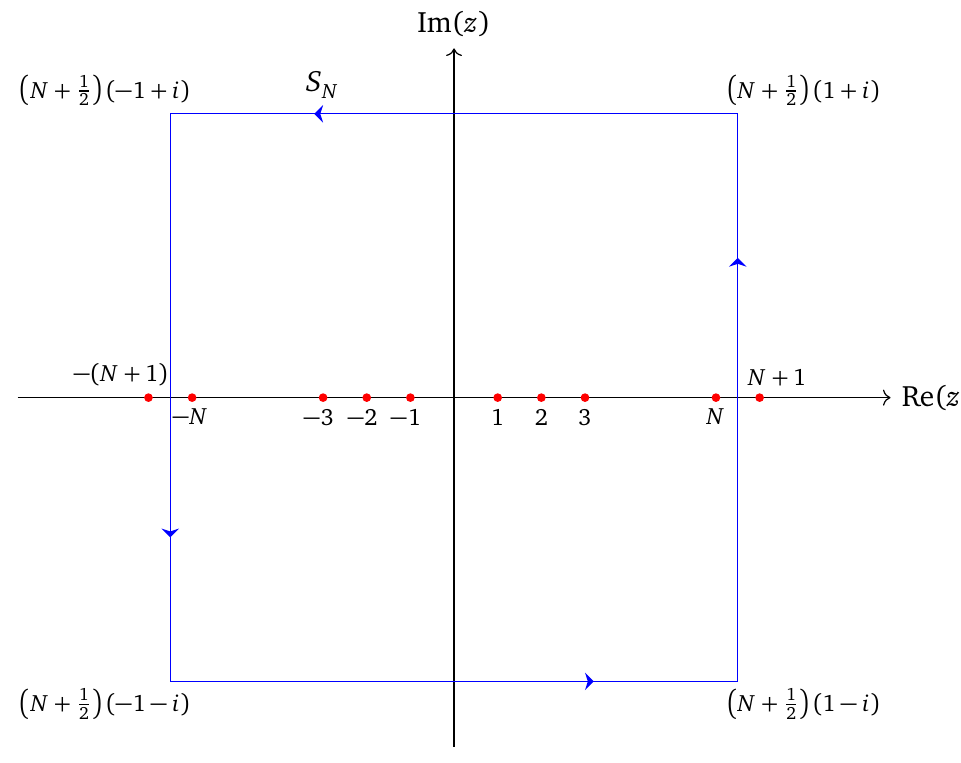
( N + 1 i ) used for an illustration in Lemma 1 2 ± ± (cid:16) (cid:17)